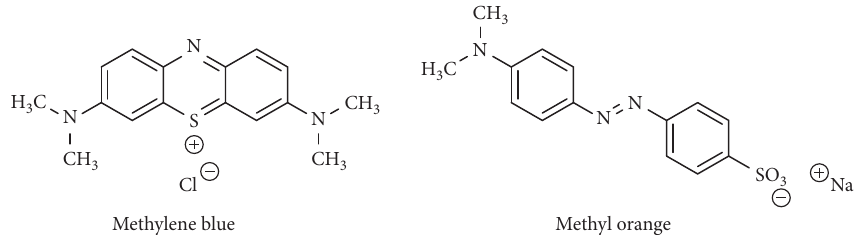
Figure 1: Chemical structures of methylene blue (MB) and methyl orange